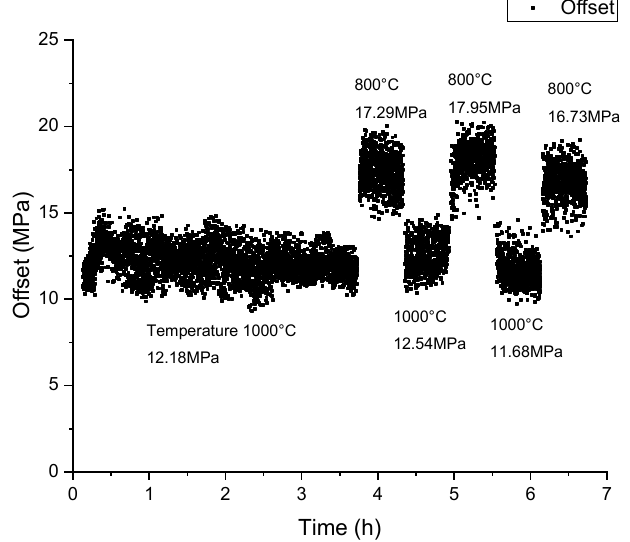
Figure 16. Offset values obtained for the different temperature plateaus of the R0.58 sample.